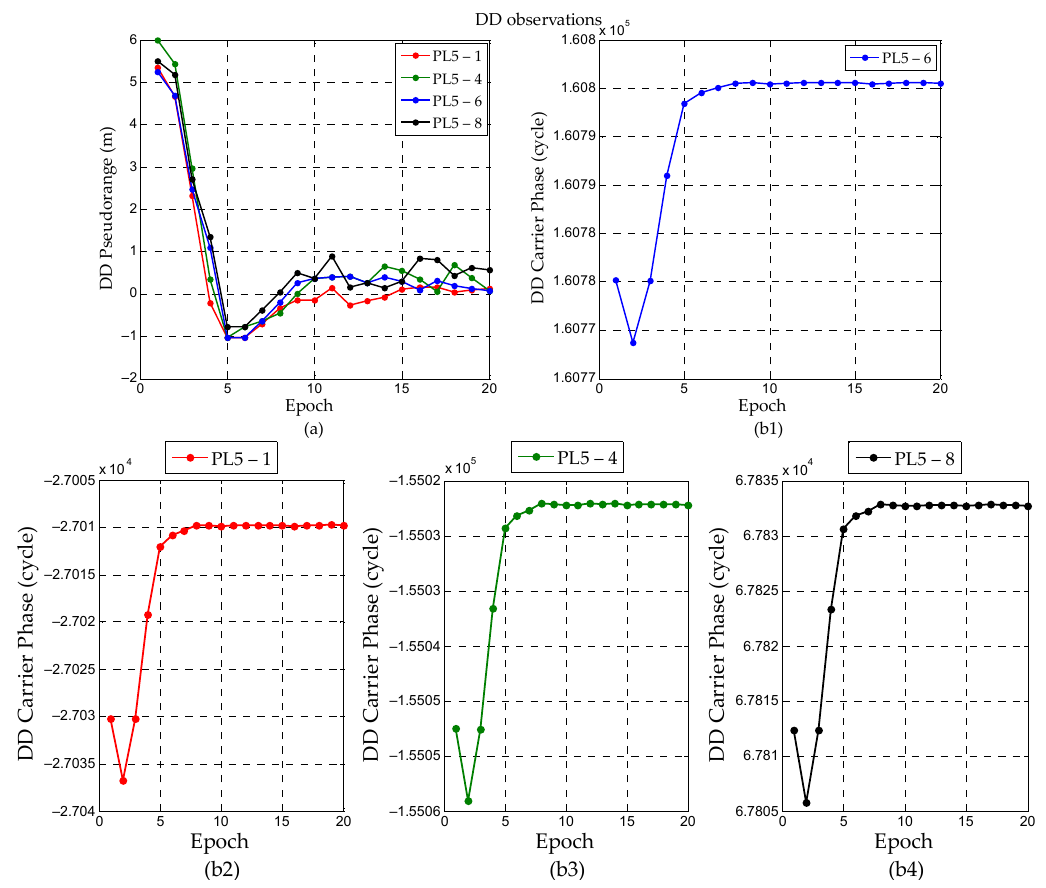
Figure 6. ( a ) Double Differenced (DD) Observations of Pseudorange, ( b1 – b4 ) DD Observations of the Carrier Phase.